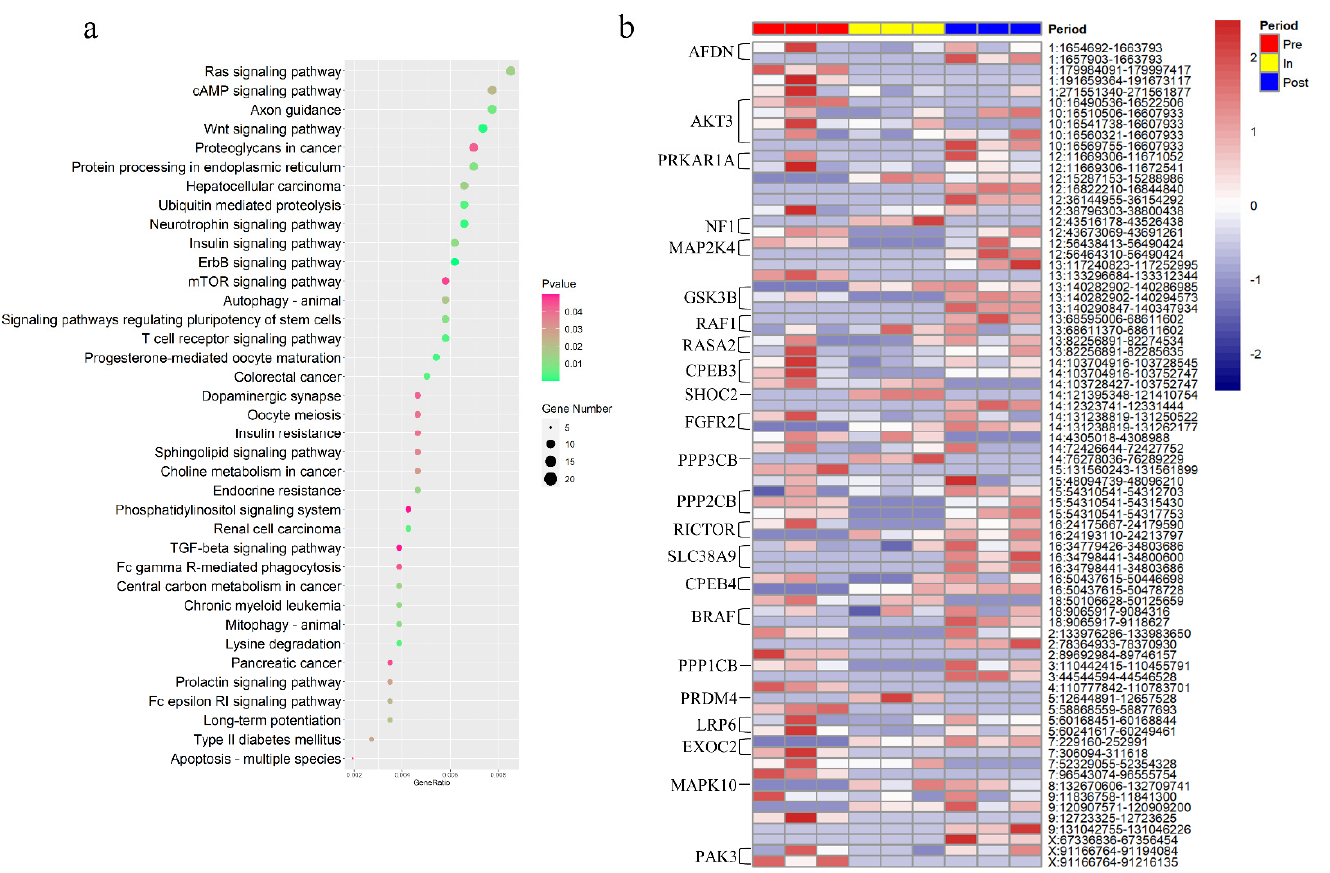
Figure 2. The Key signaling pathway of CirRNAs in pubertal transition. ( a ) KEGG analysis of all identified circRNAs ( p < 0.05). ( b ) Expression level of circRNAs involved in pubertal key pathways in pre-, in- and post-puberty.